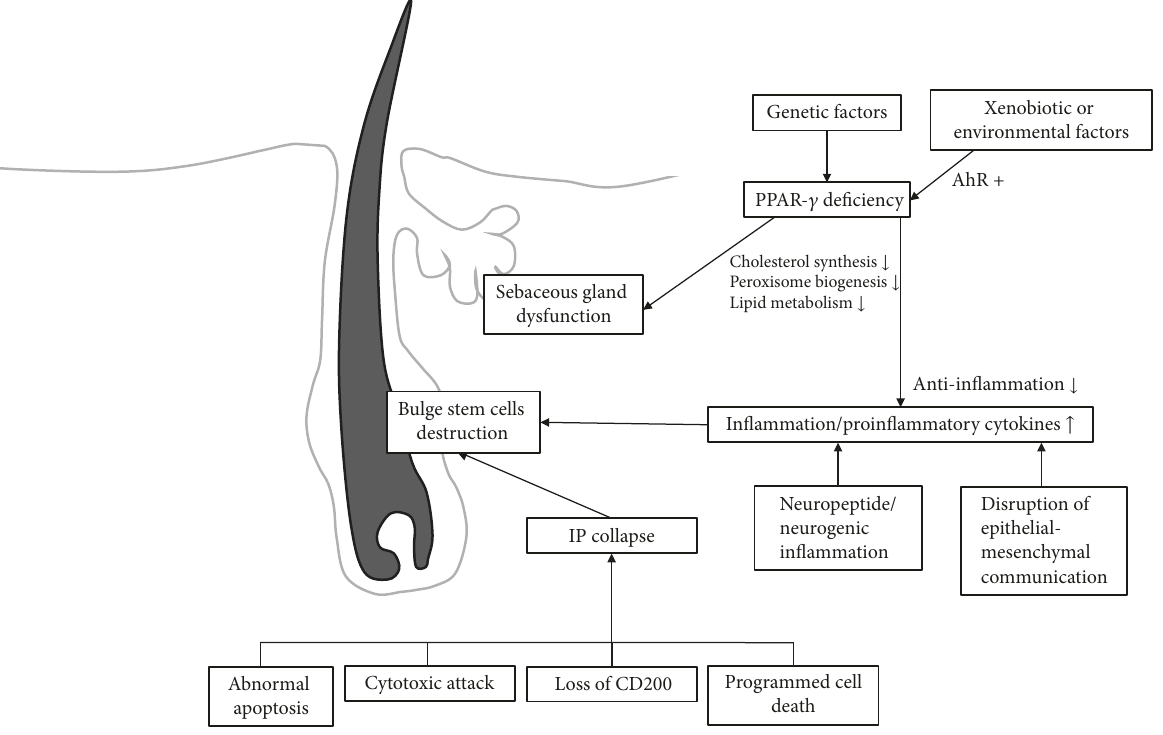
Figure 2: Possible pathogenic pathways in primary cicatricial